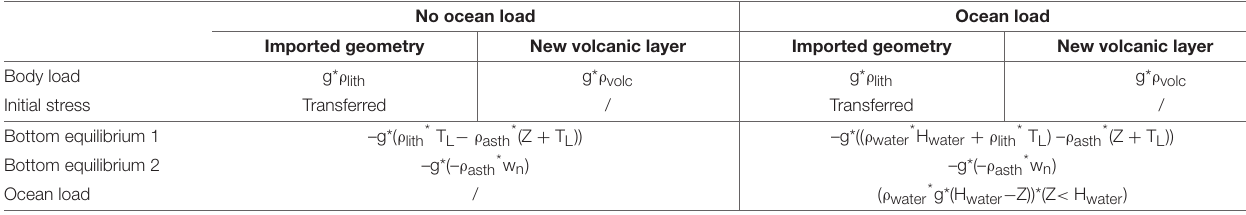
TABLE 3 | Boundary conditions of the subsequent FEMs, where w n is the vertical displacement in the n th